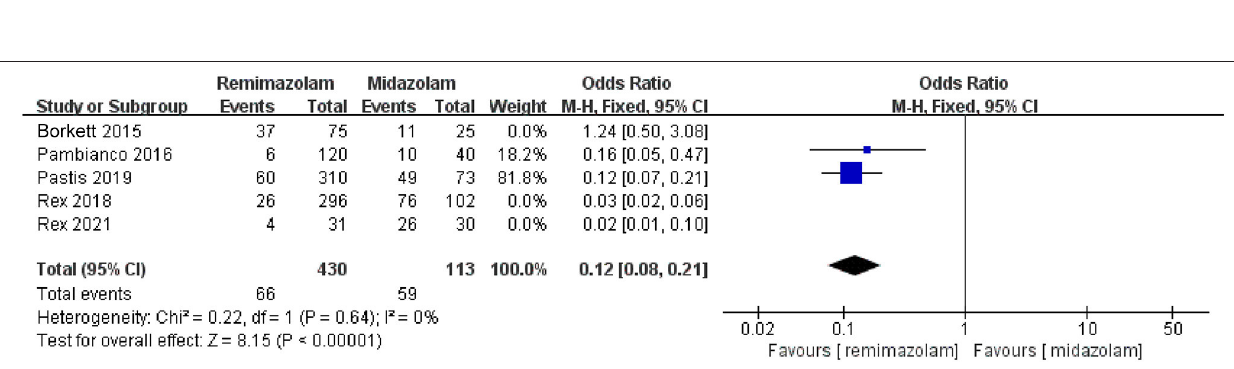
FIGURE 6 | The pooled results of sedative efficacy between remimazolam and midazolam before the sensitivity analysis.